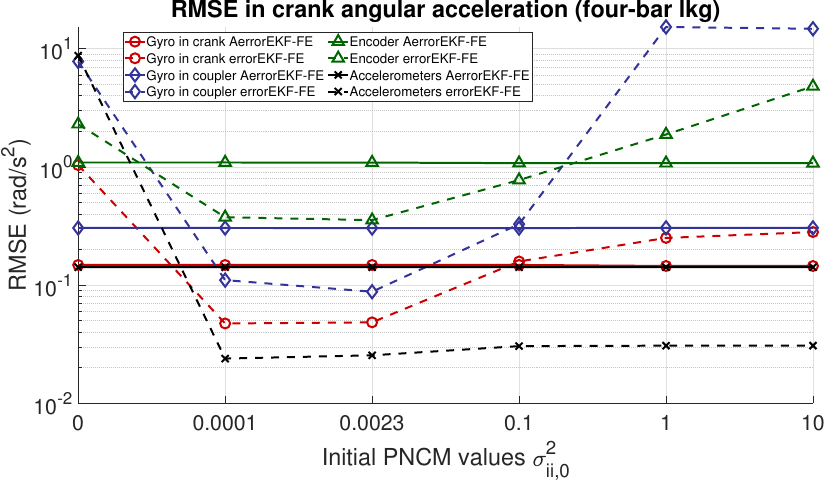
Figure 8. RMSE in the crank angular acceleration provided by the observers for the four-bar linkage.